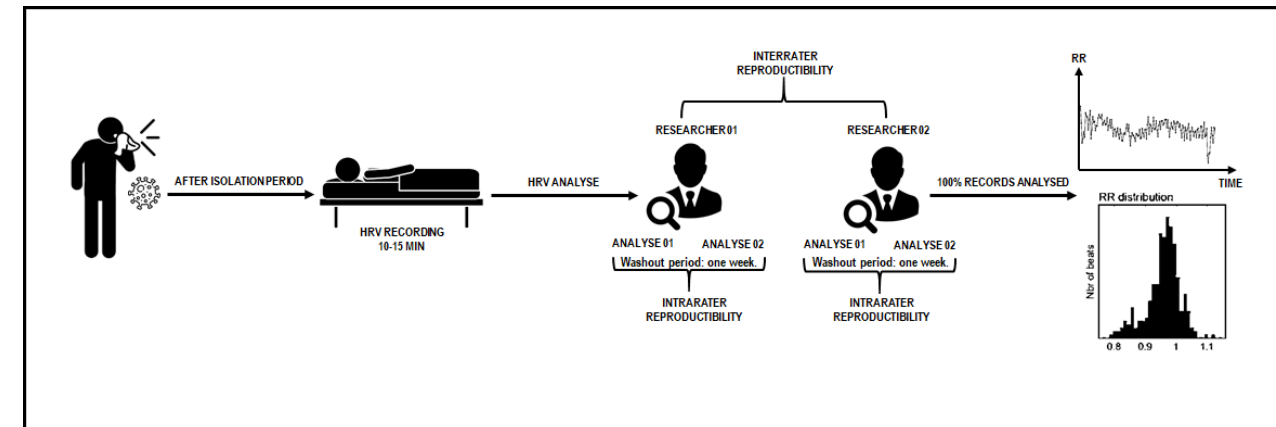
Figure 1. Study design illustration.